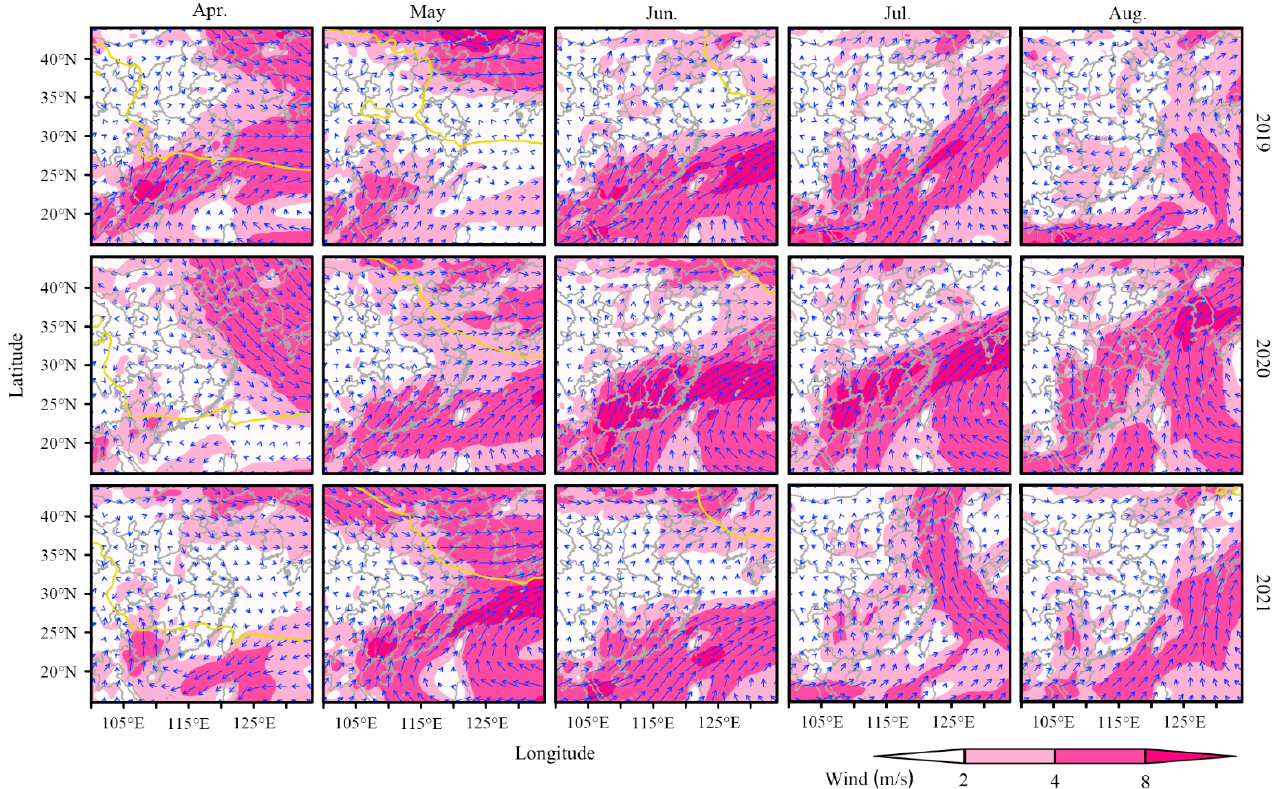
Figure 6. Average wind field at 850 hPa during the migration of Spodoptera frugiperda from April to August of 2019 to 2021. The yellow solid line is the 13.8°C isotherm.